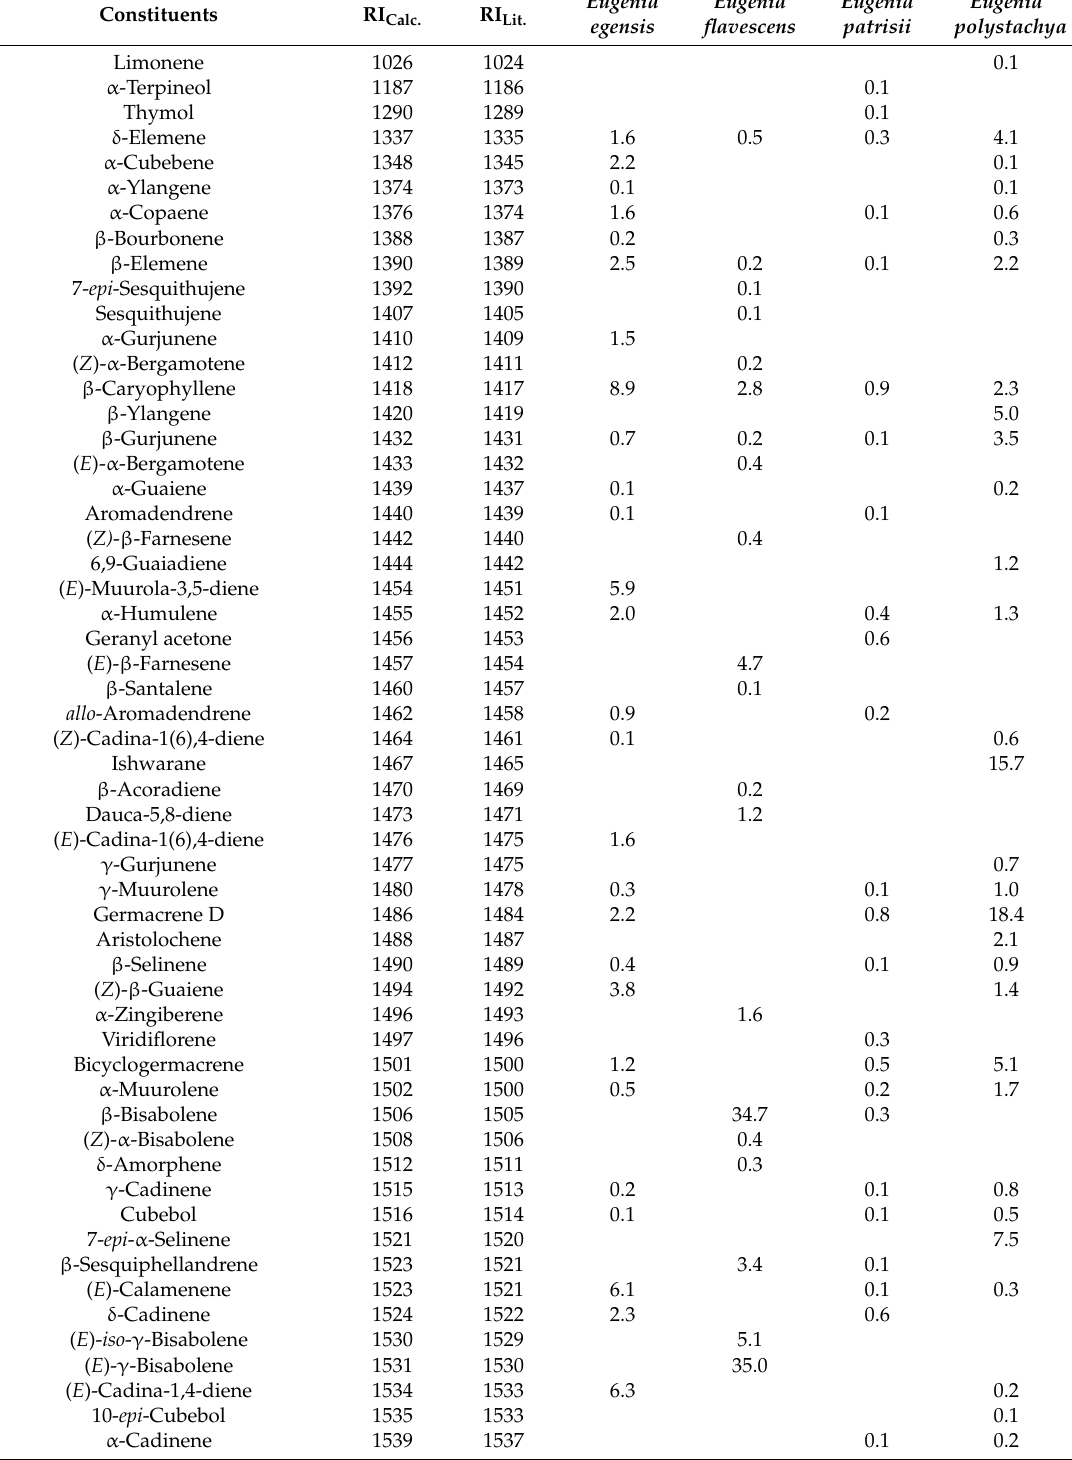
Table 1. Composition (%) of the oils of Eugenia